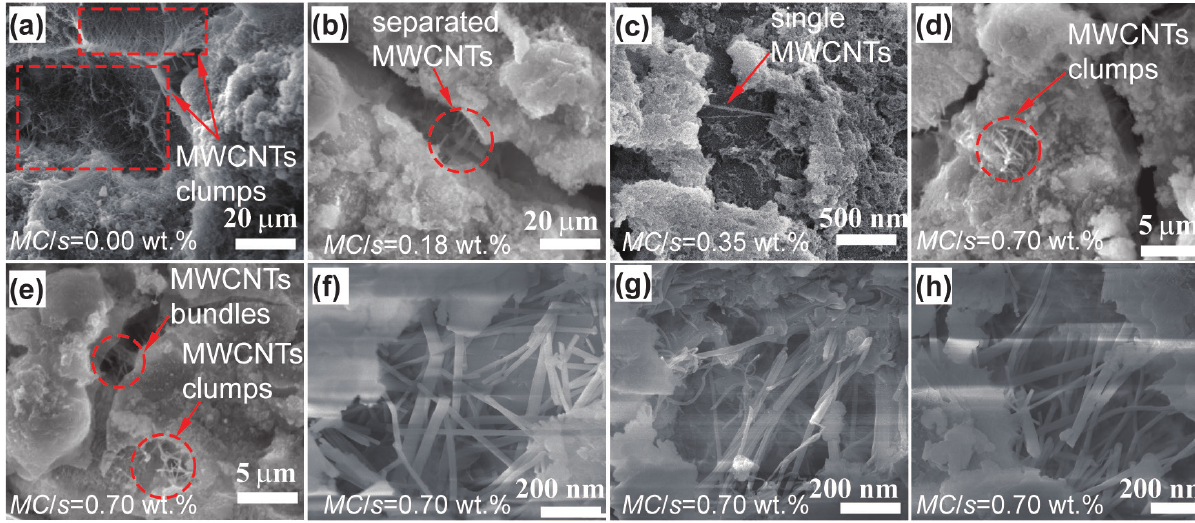
Figure 8: MWCNTs embedded in the ternary cementitious materials